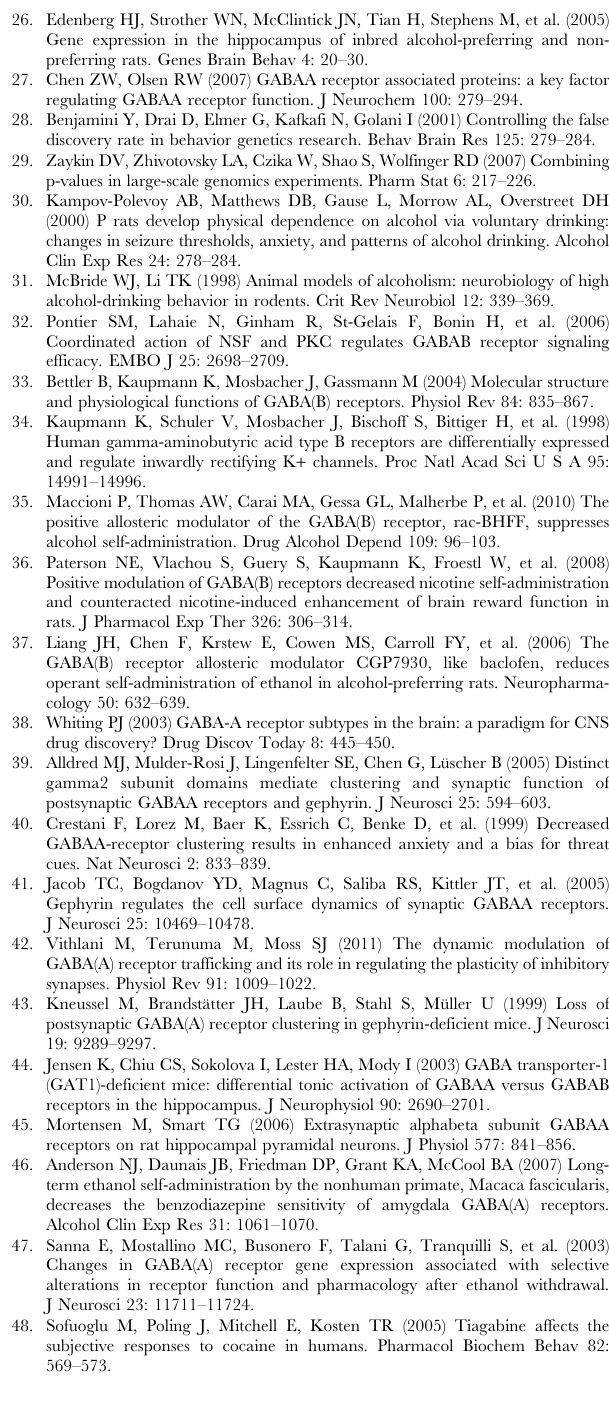
Figure S6 Down-Regulated Genes in Individual P Rats Compared with Individual NP Rats. NP1–NP 8, P1–P8: 8 NP rats and 8 P rats, respectively. qNorm = log2 transformed, quantile normalized mRNA expression